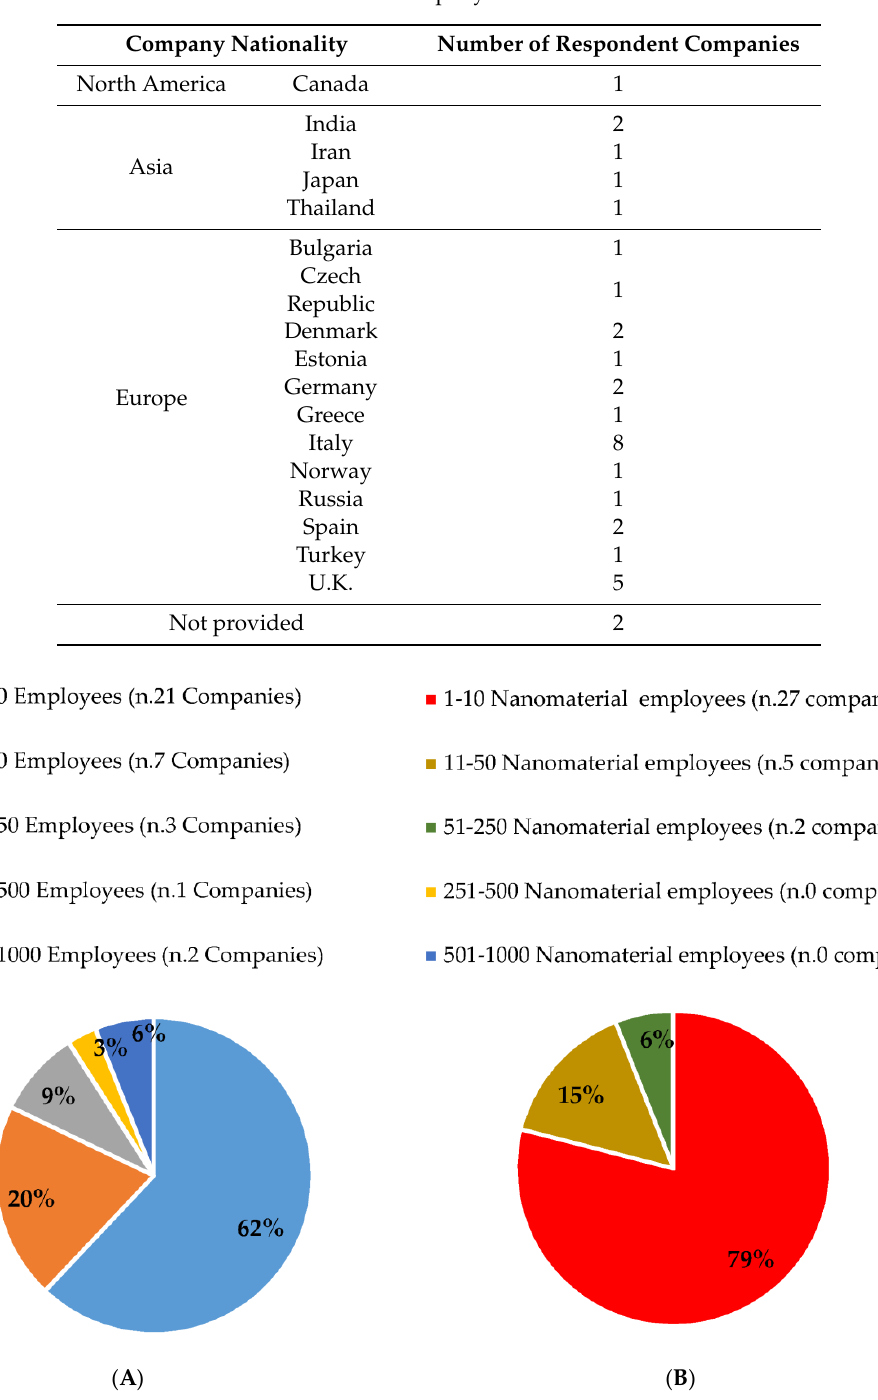
Figure 1. Workers employed in respondent companies. ( A ) Percentage of respondent companies based on the number of employed workers; ( B ) Percentage of respondent companies based on the number of nanomaterial involved workers.